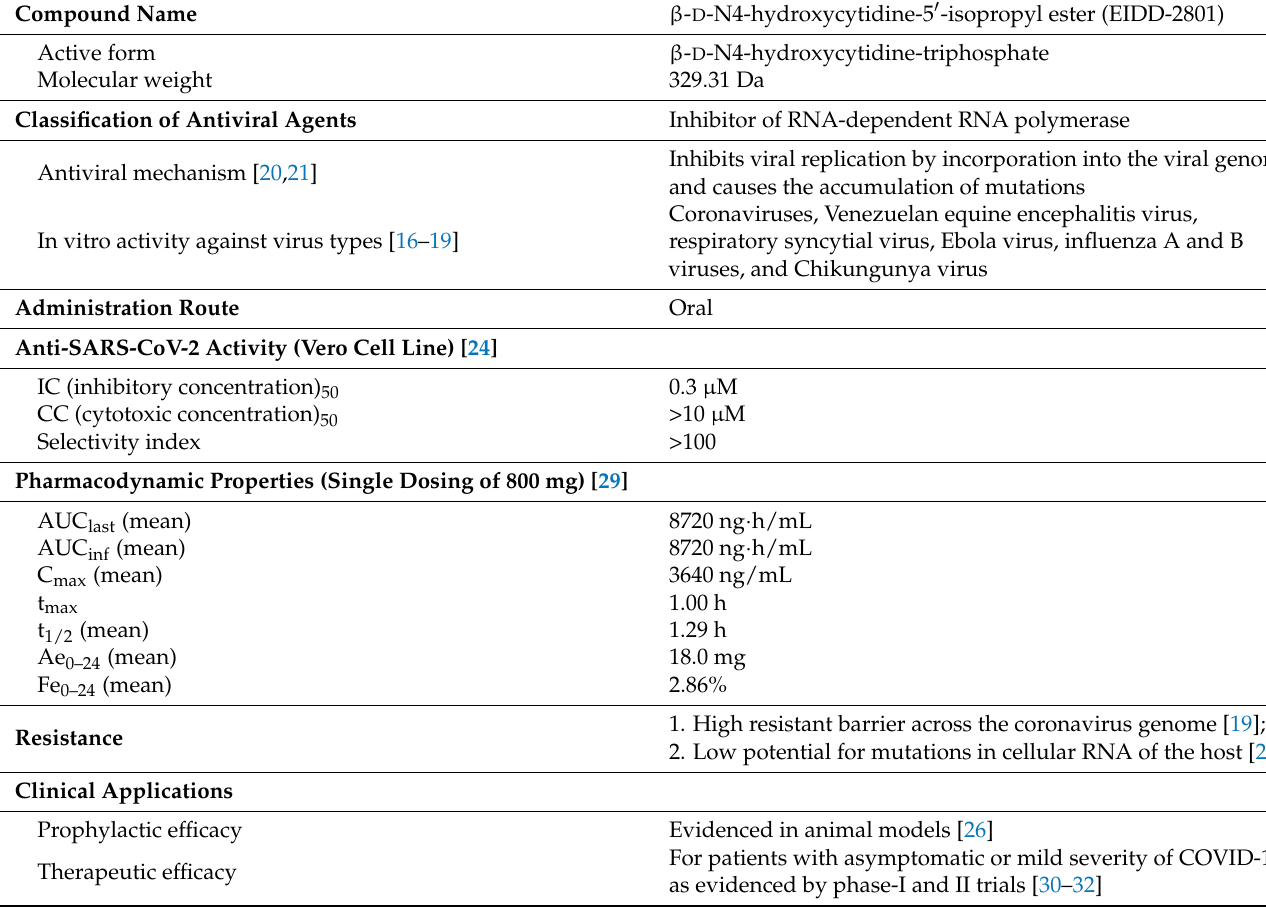
Table 1. Detailed information on